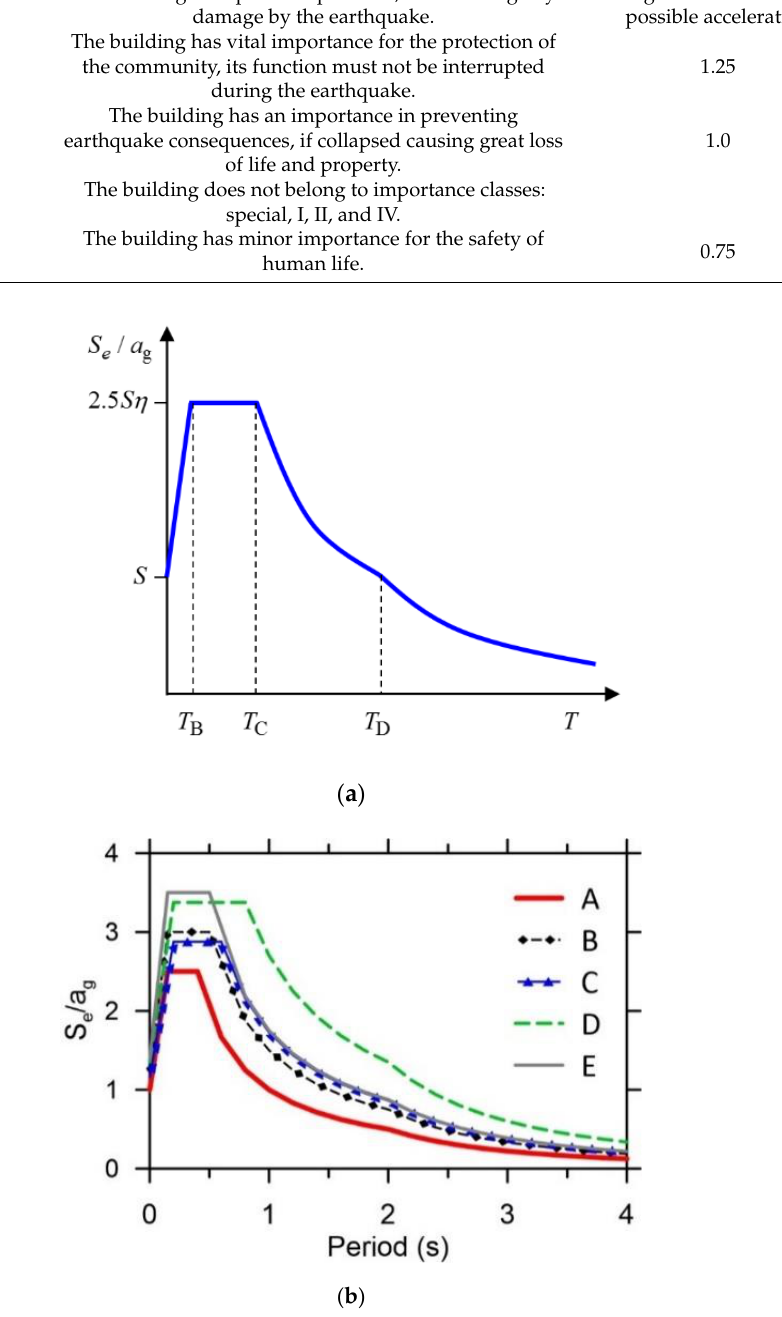
Figure 3. Elastic response spectra (5% damping) [4] : ( a ) general type and ( b ) for ground types A to E.